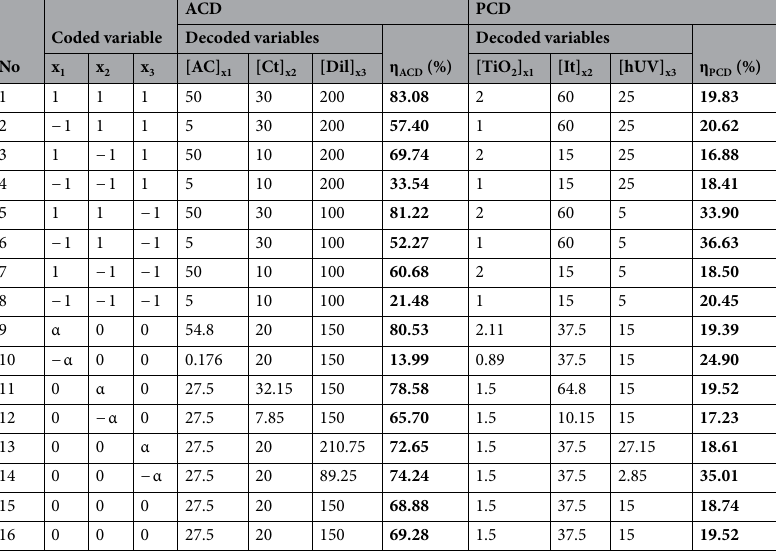
Table 2. Experiment planning and results. The bold indicated in the section Experimental